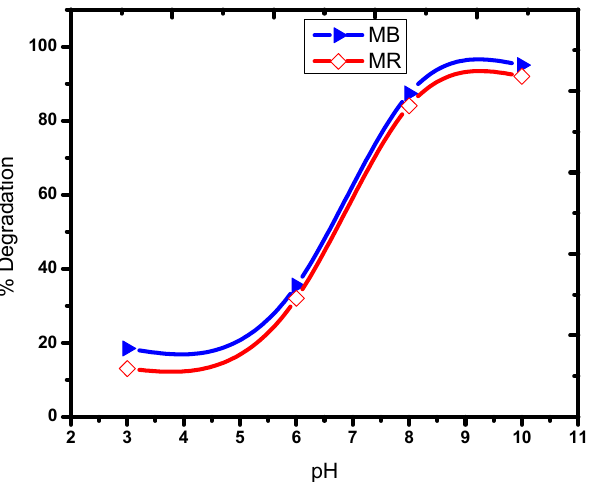
Figure 12. Effect of pH on the solar/CS-NM photocatalytic degradation of dyes. Saeed et al. [54] reported that Ag-TiO 2 photocatalytic degradation of rhodamine B